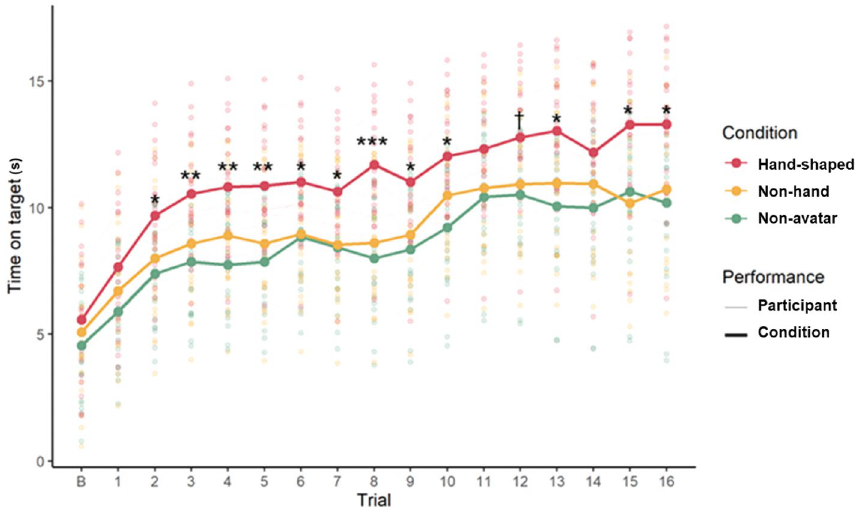
Figure 4. Group differences in the rate of learning. The rate of learning between the non-avatar group (yellow line) and the control object-shaped group (green line) is comparable, but the rate of learning of the hand-shaped avatar group (red line) is significantly superior to that of the other groups across the majority of trials. The letter “B” on the x-axis (Trial) of the graph indicates the baseline measurement. The dark line indicates the rate of learning for each condition, and the light line indicates that for each participant. The asterisks and dagger indicate significance in performance difference for each trial between the hand-shaped group and the other groups, † p < 0.1, * p < 0.05, ** p < 0.01, *** p <